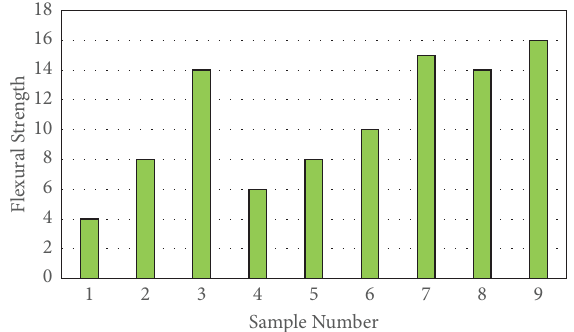
Figure 4: Variation in flexural strength against the varying wt. % of natural fibers.